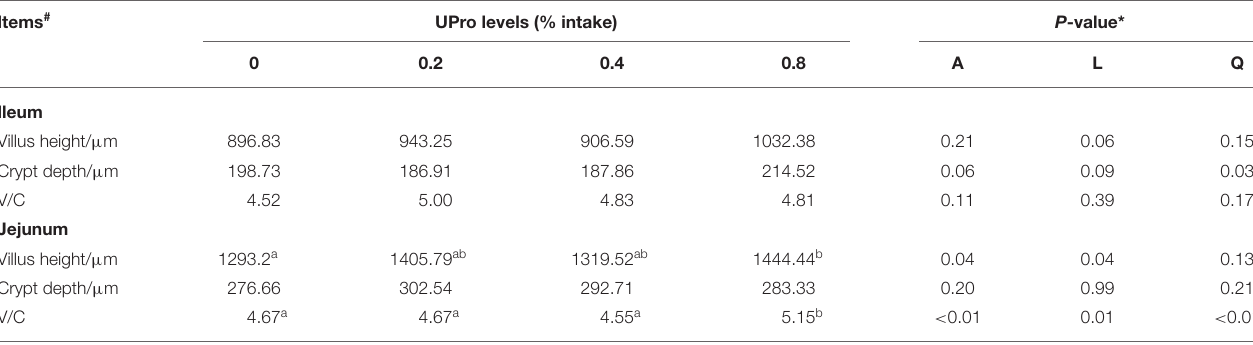
TABLE 8 | Effect of feeding UPro on intestinal morphology of laying hens.